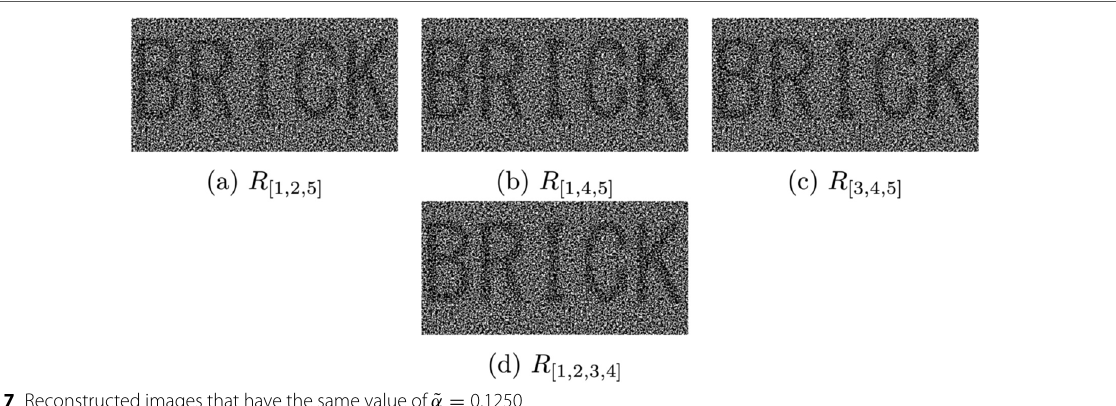
Fig. 7 Reconstructed images that have the same value of ˜ α =